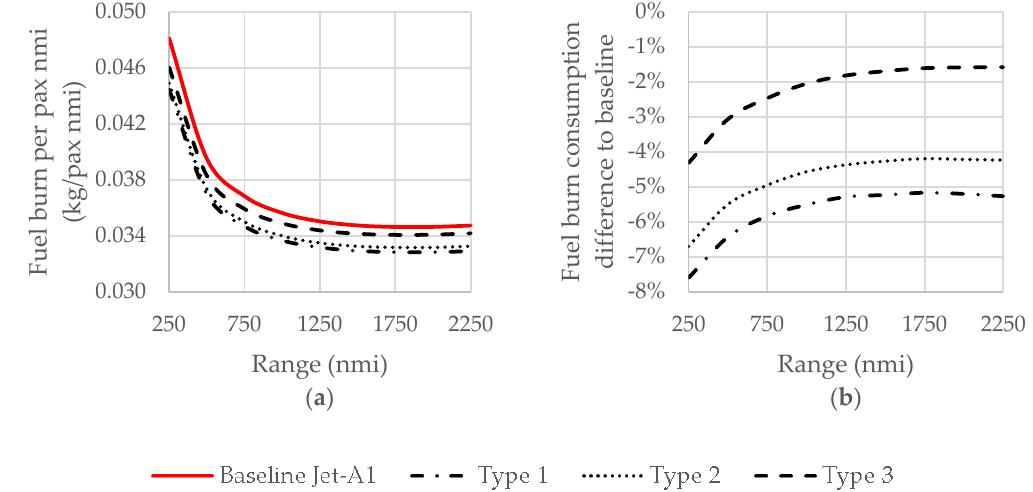
Figure 12. ( a ) Fuel burn per pax nmi against range and ( b ) the corresponding difference from the baseline.